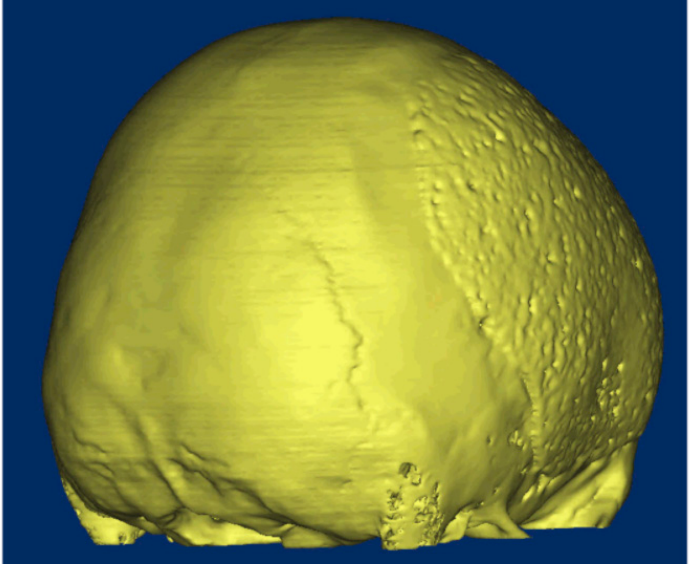
Figure 1. A 16-year-old patient came to our attention after a traumatic brain injury (TBI) for which a decompressive craniectomy (DC) was required. After 4 months, the attending neurosurgeons decided that the patient was stable, and it could be implanted. The surgical procedure and the postoperative follow-up were uneventful. At 8 months follow-up, the CT-scan showed a complete osteointegration.